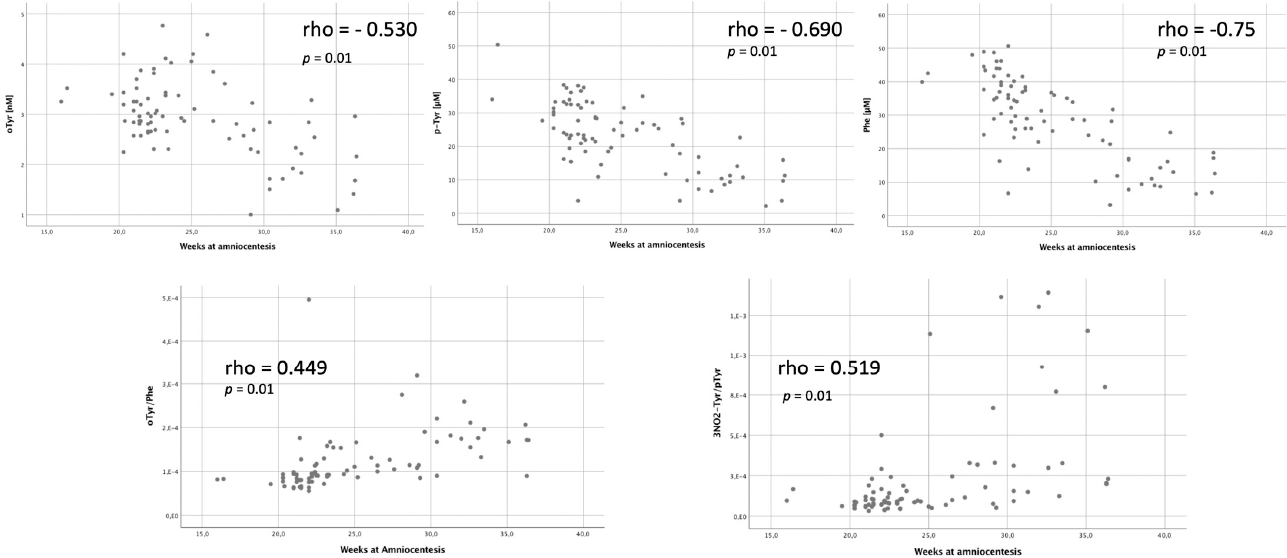
Figure 4. Correlation of OS Biomarkers and gestational age at the time of amniocentesis. o-Tyr: ortho-Tyrosine, p-Tyr para-Tyrosine, Phe Phenylalanine, 3NO 2 -Tyr: 3-nitro-Tyrosine. OS biomarkers were analyzed according to (1) aortic flow obstruction, (2) expected cyanosis after birth, and (3) our proposed CHD